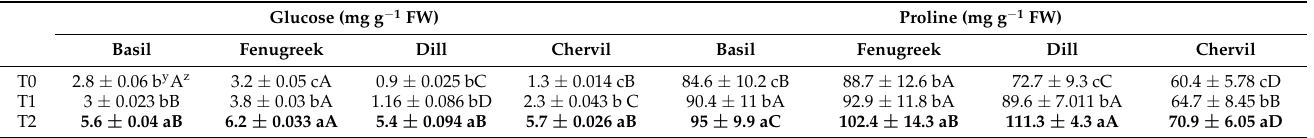
Table 5. Glucose and proline contents (mg g − 1 FW) of basil, fenugreek, dill, and chervil microgreens cultivated under three light-emitting diode (LED) lamp spectra. The best light treatment, for each plant species, is bold.